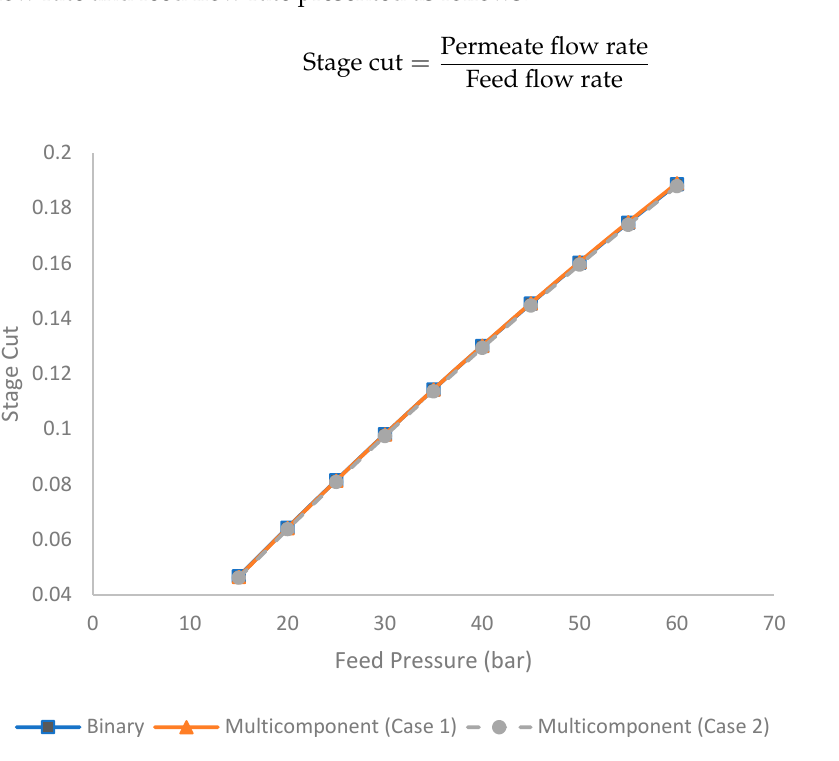
Figure 5. Evolution of stage cut under different feed pressures for binary and multicomponent sys- tems.